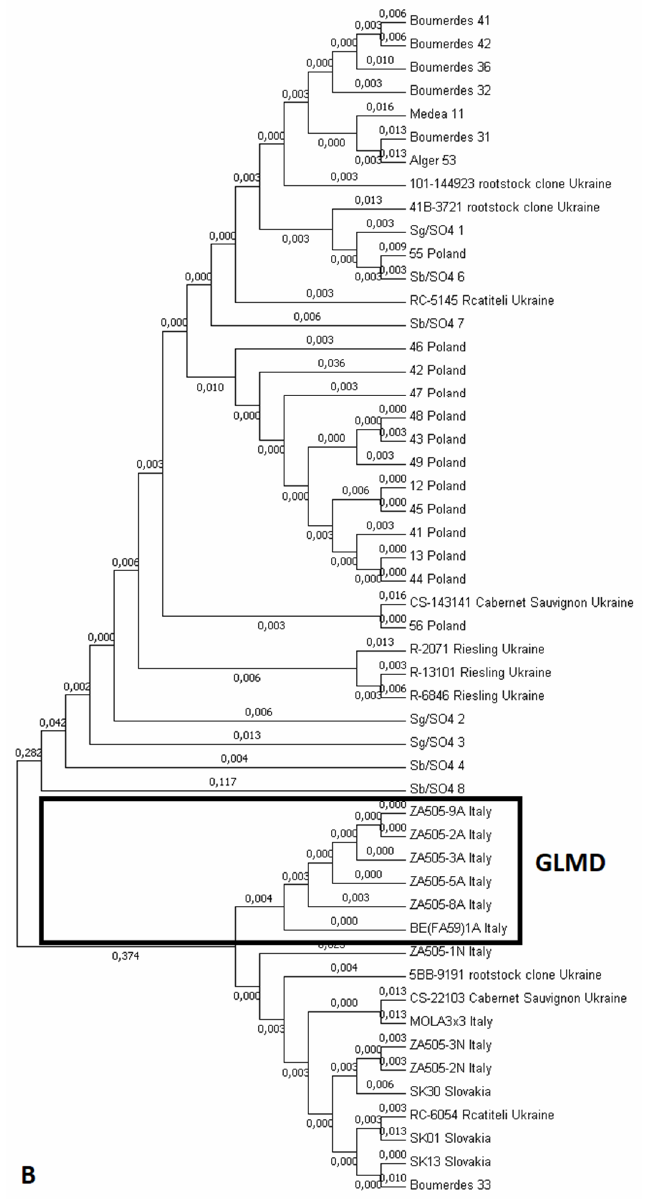
Figure 2. ( A ) molecular phylogenetic analysis of GPGV MP/CP sequences. ( B ) Phylogenetic analysis of the GPGV RdRp domain. The isolates in the box are GLMD causing GPGV isolates.